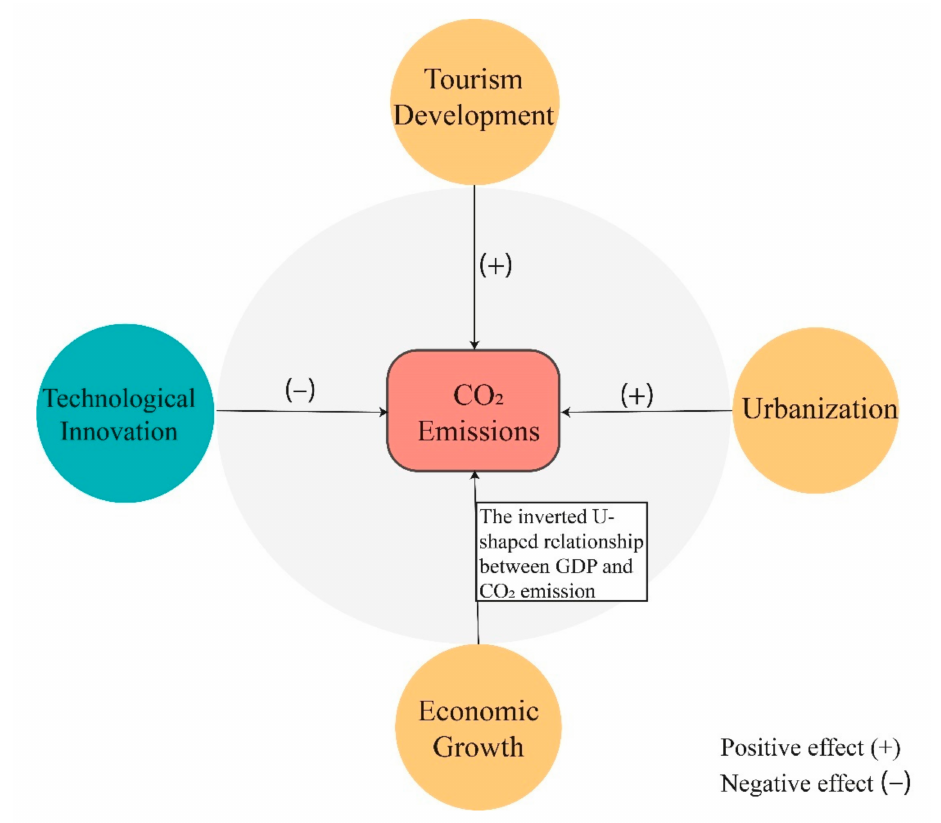
Figure 5. Graphical representation of results based on AMG and CCEMG